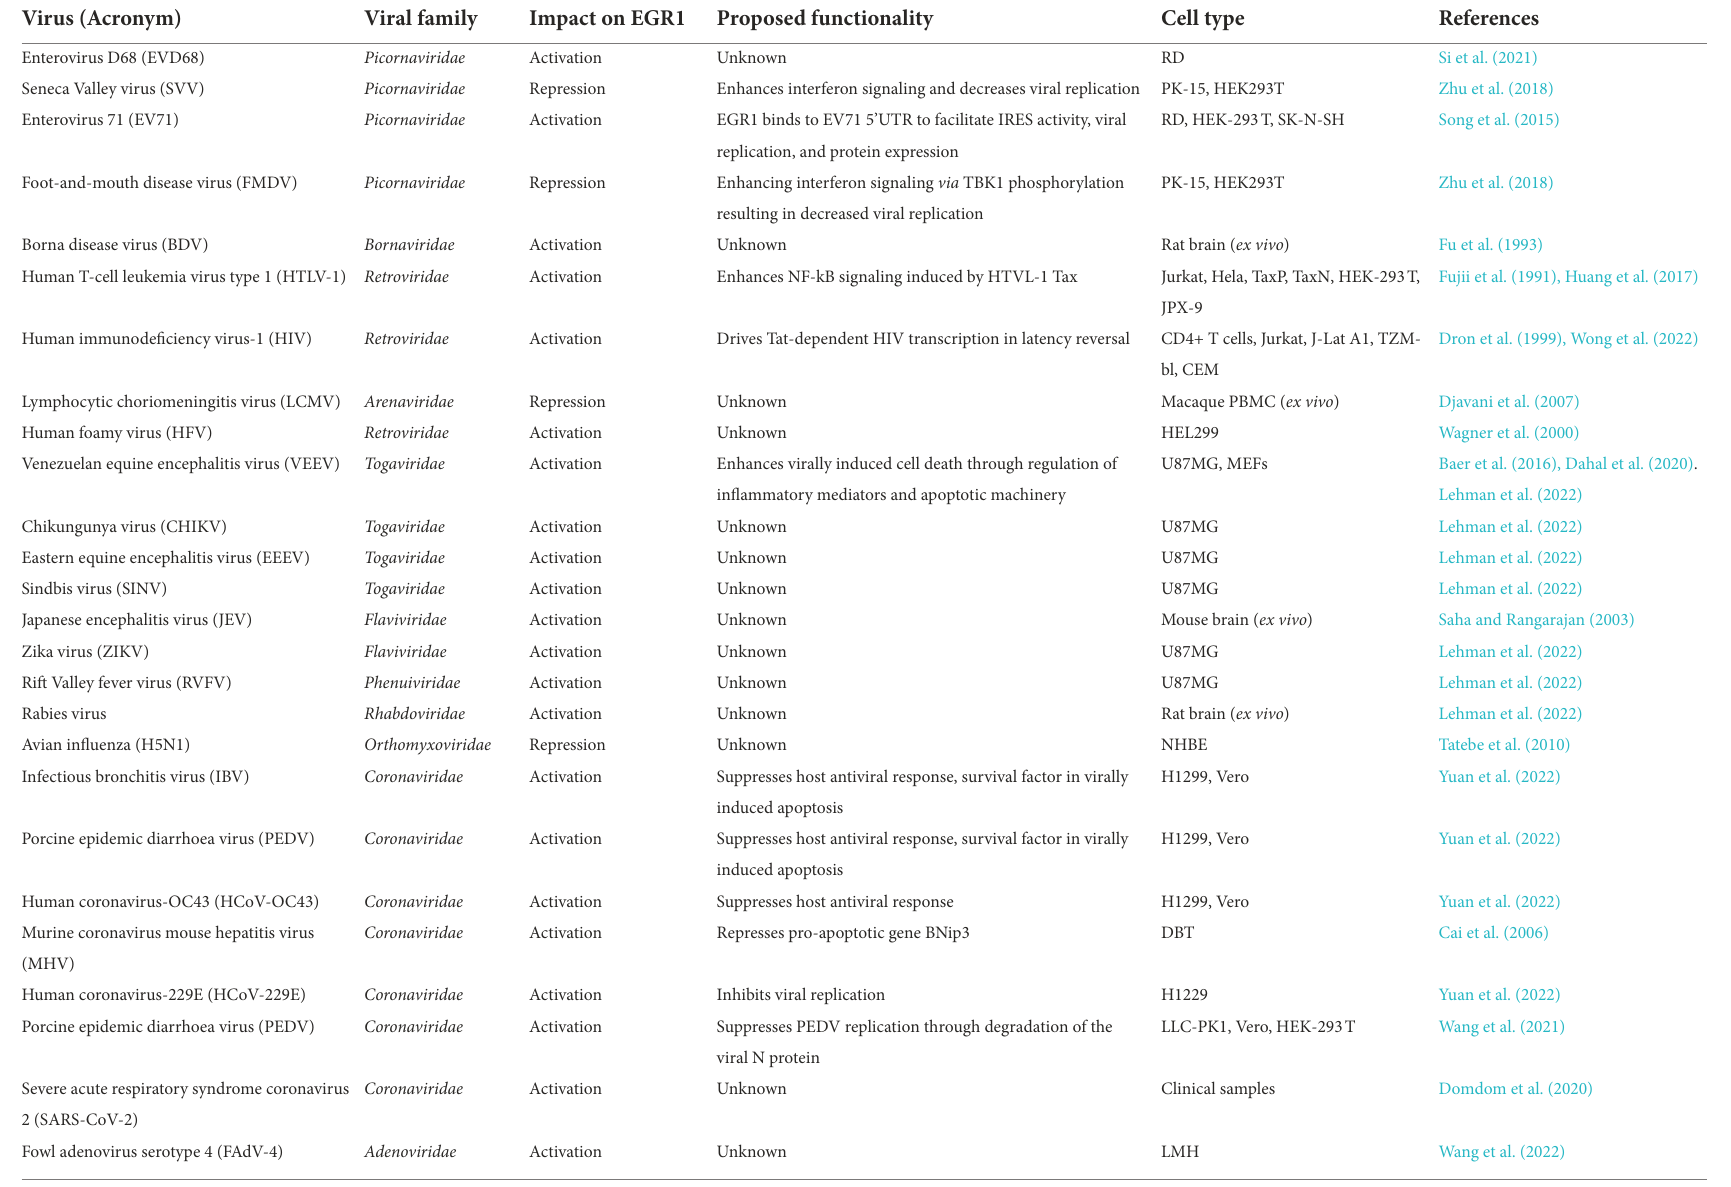
TABLE 2 RNA viral infections implicating